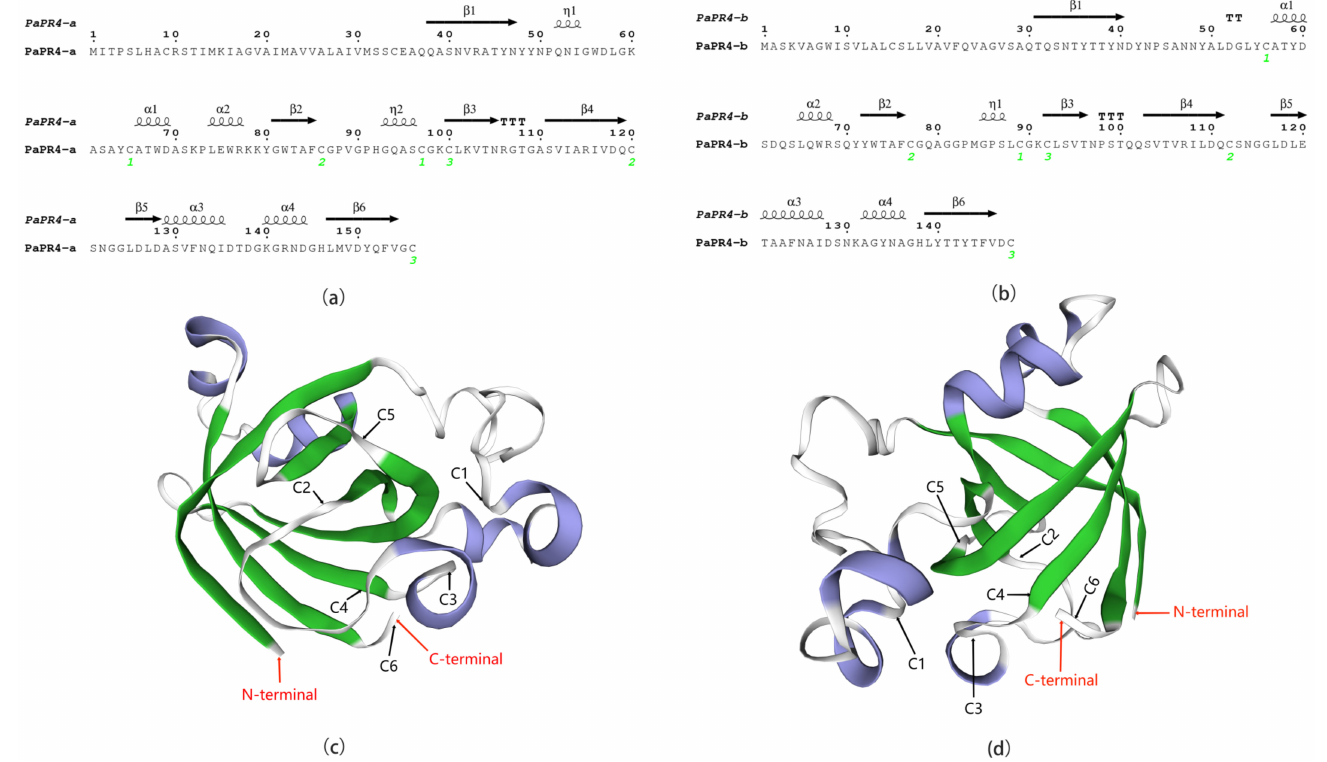
Figure 2. Structural analysis of PaPR4-a and PaPR4-b. ( a , b ) represent the secondary structures of PaPR4-a and PaPR4-b. The α -helices, η -helices, β -chains and TTT are indicated. The numbers in green represent the positions of the three disulfide bonds. ( c , d ) represent the tertiary structures of PaPR4-a and PaPR4-b constructed using the Barwin-like protein of papaya as template. The α -helices and β -chains are indicated in blue and green, respectively, while the red arrows indicate the N-termini and C-termini of the proteins. C1–C6 indicate the six cysteines that formed three disulfide bonds in the